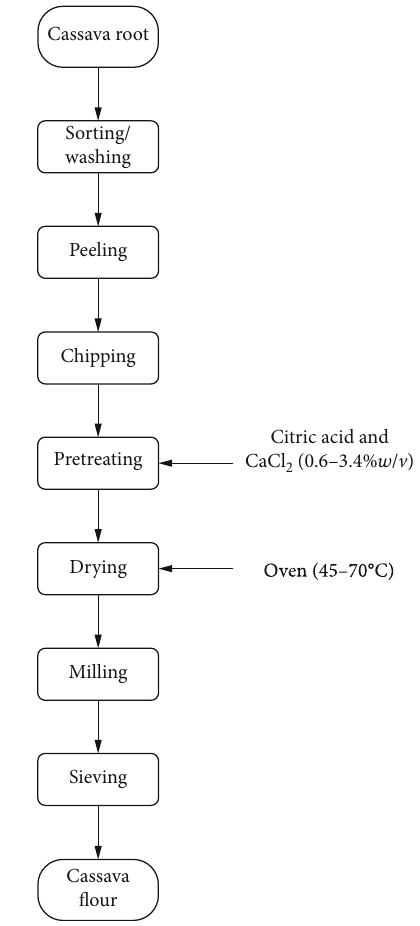
Figure 1: Process fl ow chart for pretreated cassava fl